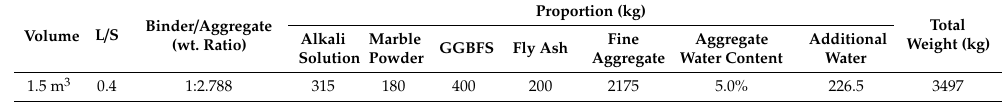
Figure 10. Samples at a ready-mixed plant. Table 11. Mix proportions of marble-based geopolymer mortar for making Jersey barriers at a ready-mixed